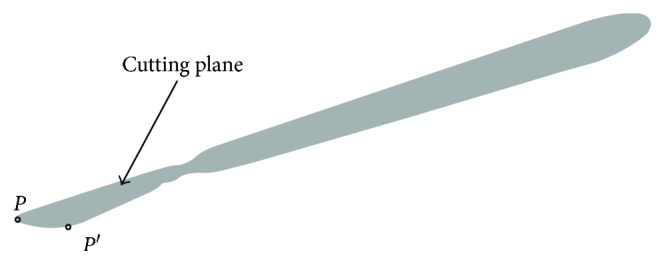
Virtual scalpel.